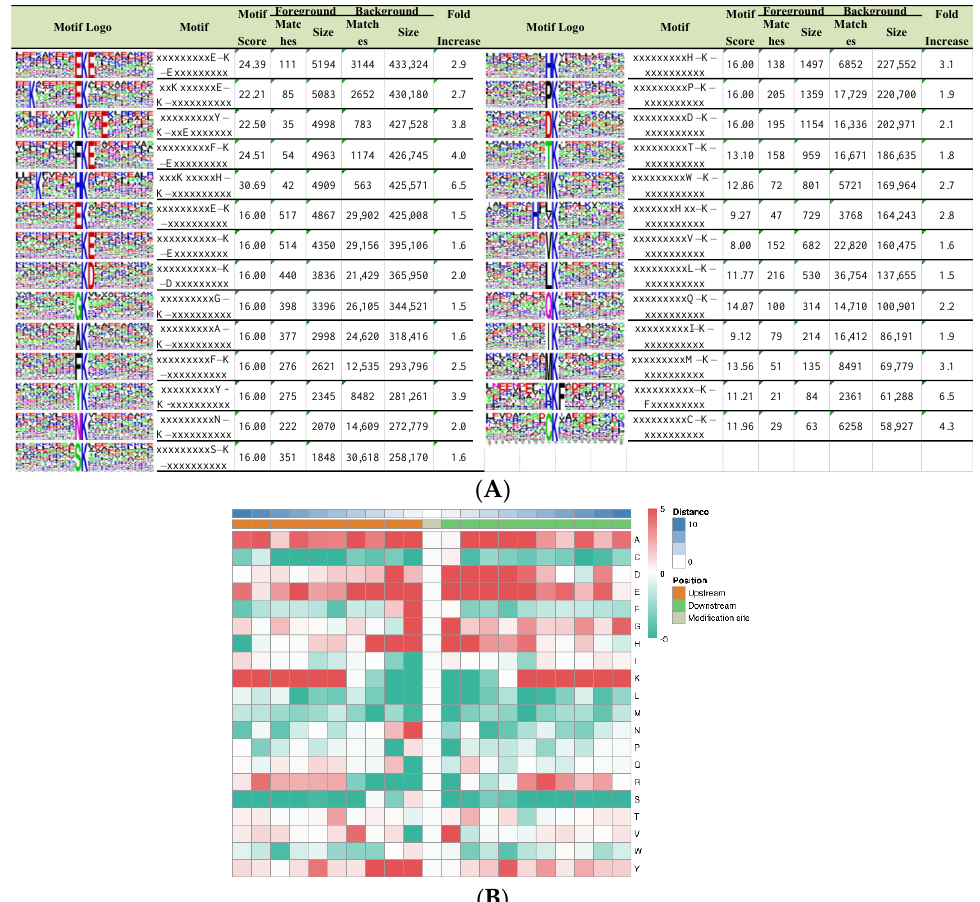
Figure 2. Properties of lysine-crotonylated peptides. ( A ) Crotonylation sequence motifs for ±10 amino acids around the lysine crotonylation sites. ( B ) Heat map of the amino acid compositions of the crotonylated sites.